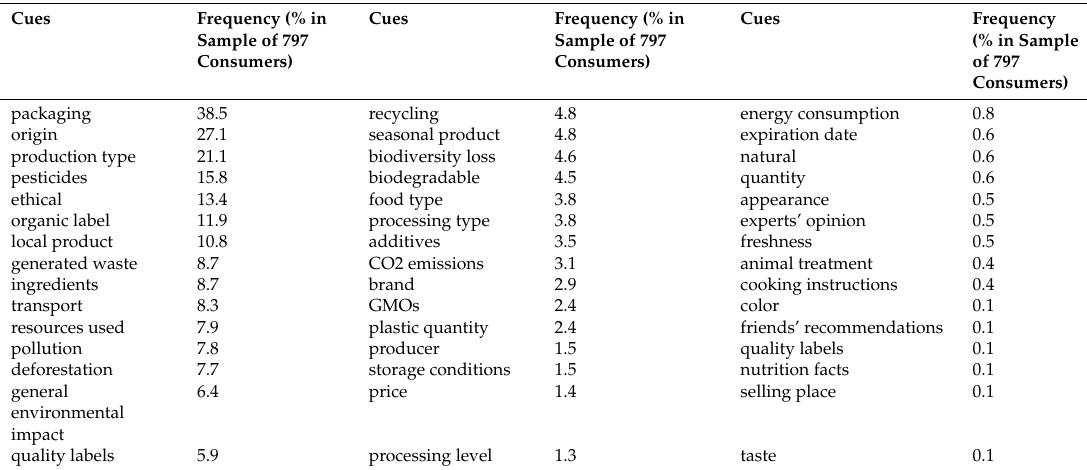
Table 9. Percentage of tested consumers who declared they use often a specific cue for the evaluation of food impact on the natural environment (unaided